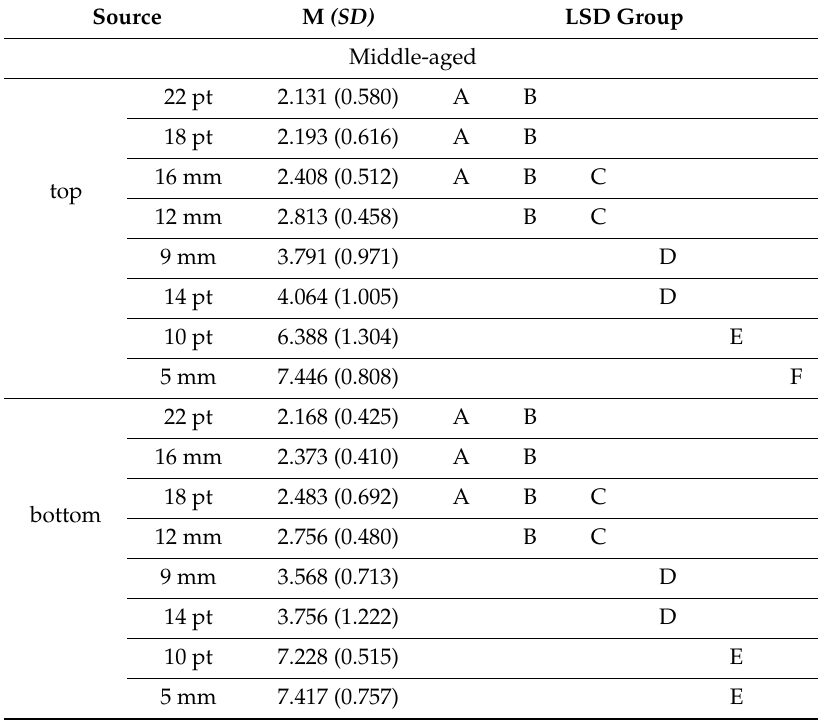
Table 5. LSD table of presentation positions and button size for the middle-aged